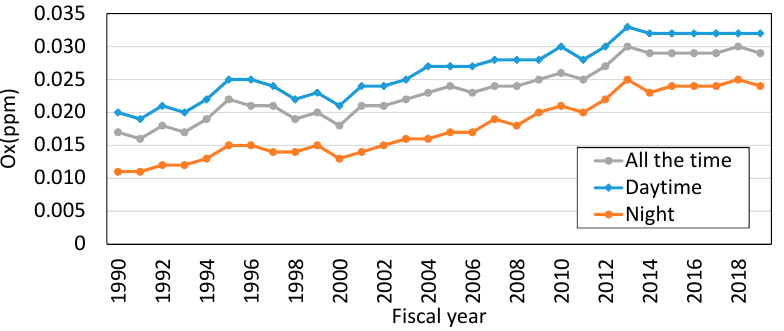
Figure 3. Trends in the annual averages of Ox. Ox (All the time): annual averages of hourly Ox for all nine General sta. Ox (Daytime): annual averages of hourly Ox for all nine General sta. from 6 a.m. to 8 p.m. Ox (Night): annual averages of hourly Ox for all nine General sta. from 12 a.m. to 5 a.m. and 9 p.m.–12